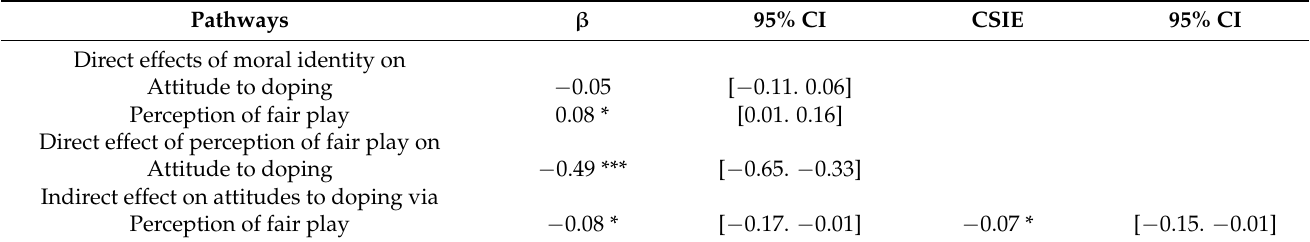
Table 3. Direct and indirect effects of moral identity on attitudes to doping among